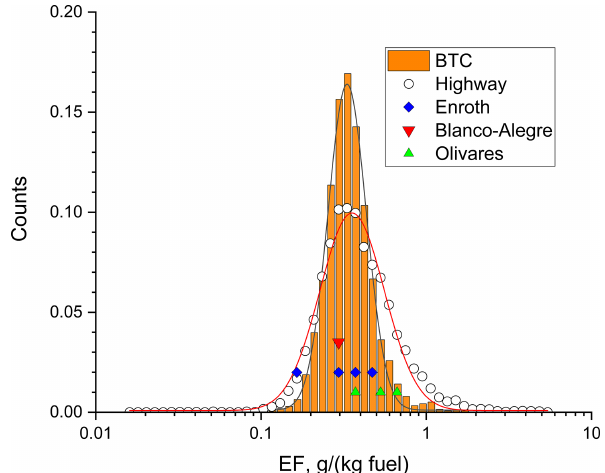
Figure 7. Distributions of the emission factors originating from traf- fic at BTC (all data) and the highway. Lognormal functions were fit- ted on the points with parameters summarized in Table 5. Colorized scatter symbols refer to the literature data (only X axis concerned). See more details in Table